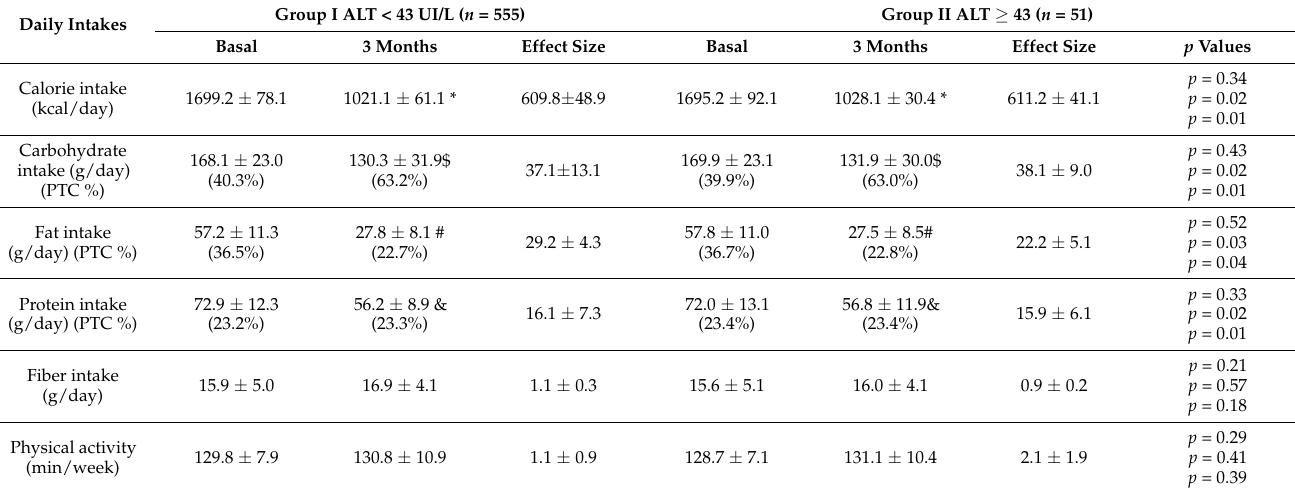
Table 3. Average daily intakes and physical activity at baseline time and after 3 months of intervention (mean ± standard